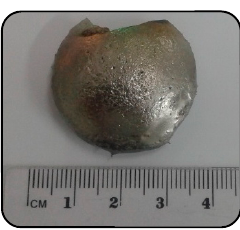
Figure 12. Exemplary cast button of HEAs.